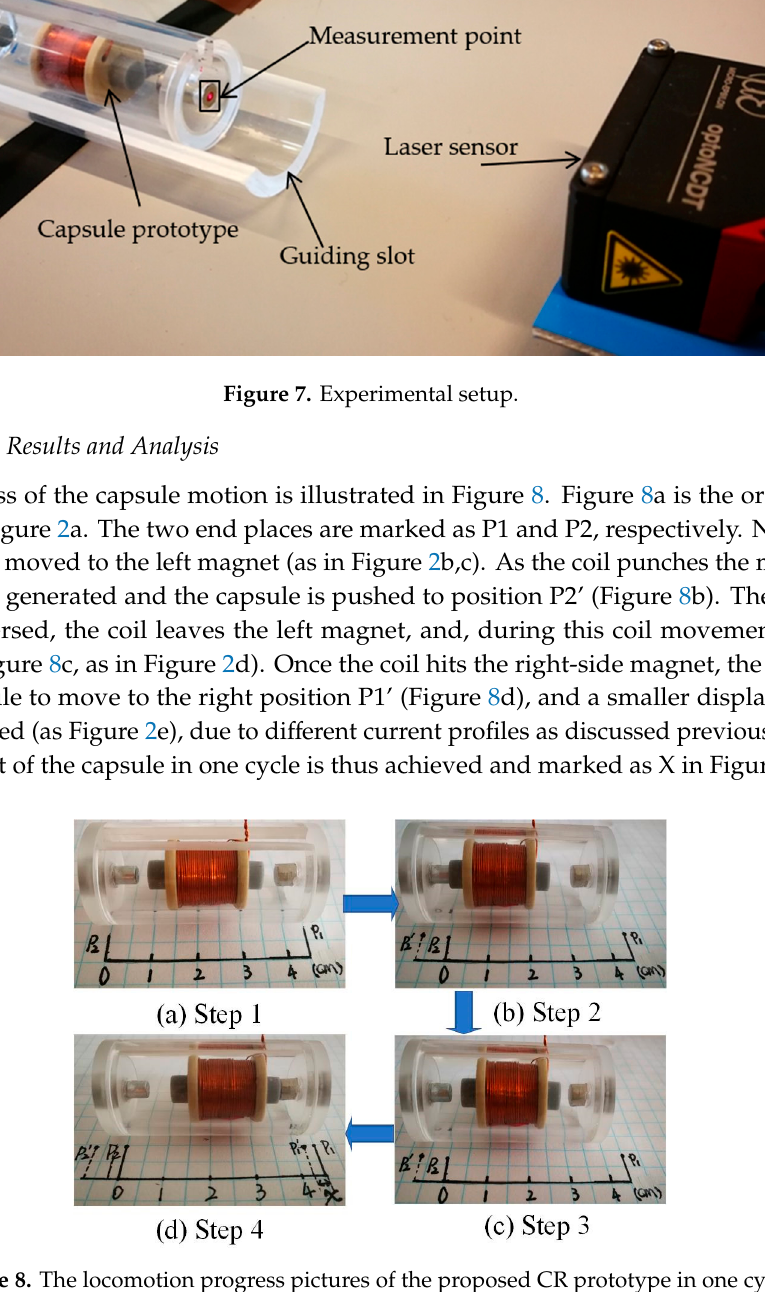
Figure 8. The locomotion progress pictures of the proposed CR prototype in one cycle.